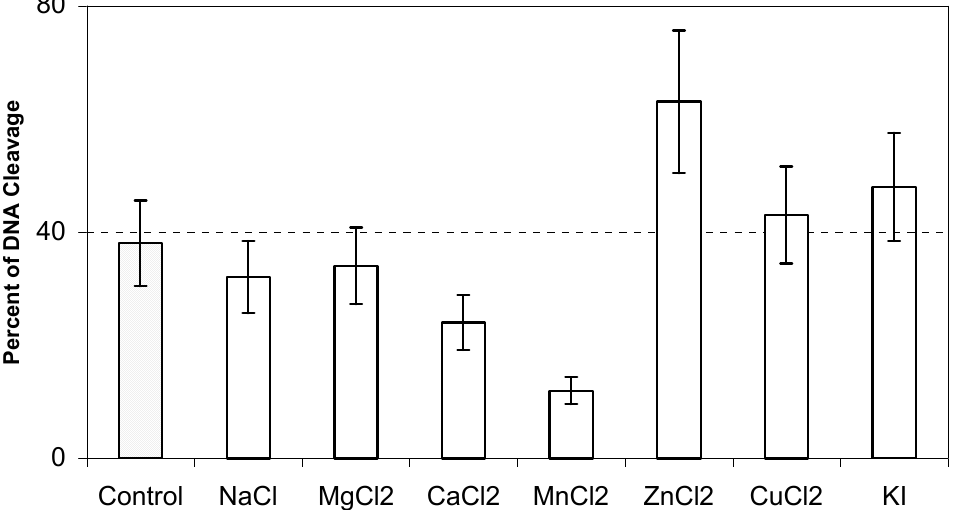
Figure 3. Effect of biologically relevant ions on UVA-induced DNA cleavage by 6 µ M 1-AP in 10 mM sodium phosphate buffered solution with 10% MeOH. Errors for % of DNA cleavage are usu- ally <20%. and CuCl 2